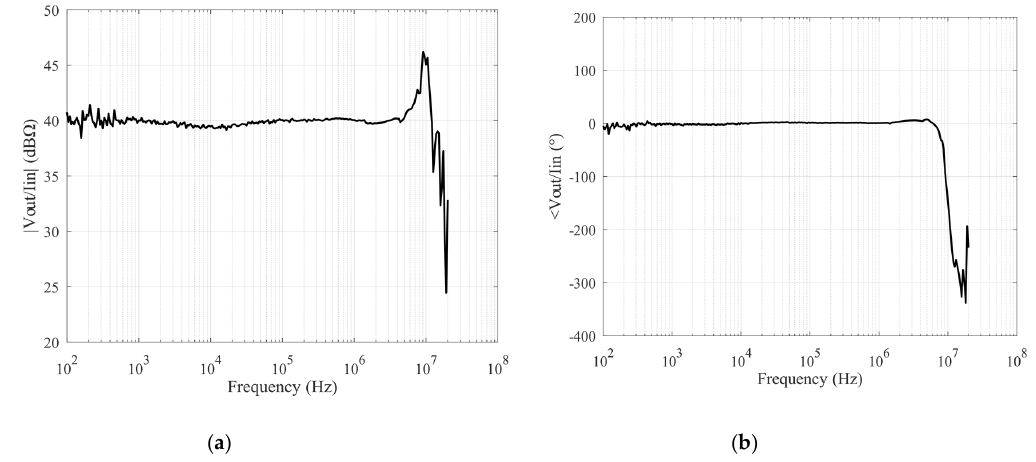
Figure 12. Measured transimpedance characteristics: magnitude ( a ) and phase ( b ).